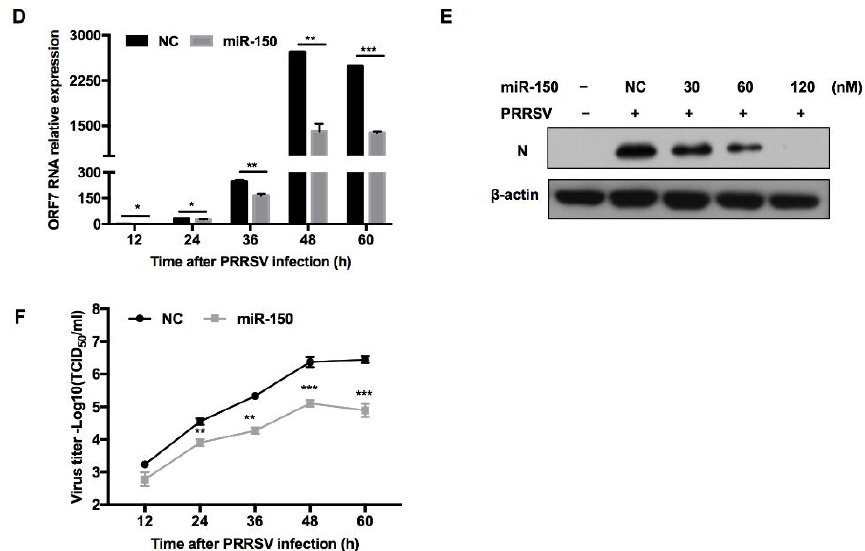
Figure 4. miR-150 inhibits PRRSV replication. PAMs were transfected with miR-150 mimics or miR-150 inhibitors (miR-150-i) at the indicated concentration for 12 h, followed by infection with HV-PRRSV (HV isolate) for 36 h at an MOI of 0.01. ( A ) Cells were then fixed for immunofluorescent staining of PRRSV N protein. ( B , C ) qRT-PCR was used to analyze ORF7 expression. ( E ) Cells were harvested for PRRSV protein N detection using Western blot analysis. ( D , F ) PAMs were transfected with miR-150 mimics or negative control (NC) at a final concentration of 60 nM, followed by inoculation with medium alone, or HP-PRRSV (HV isolate) at an MOI of 0.01. Total RNA was extracted at 12, 24, 36, 48, and 60 h, respectively. qRT-PCR was used to analyze ORF7 expression ( D ). Culture supernatants were collected to analyze virus yields ( F ). The data are representative of three independent experiments (means ± SEM). p values were analyzed using a t -test. *, p < 0.05; **, p < 0.01; ***, p < 0.001.